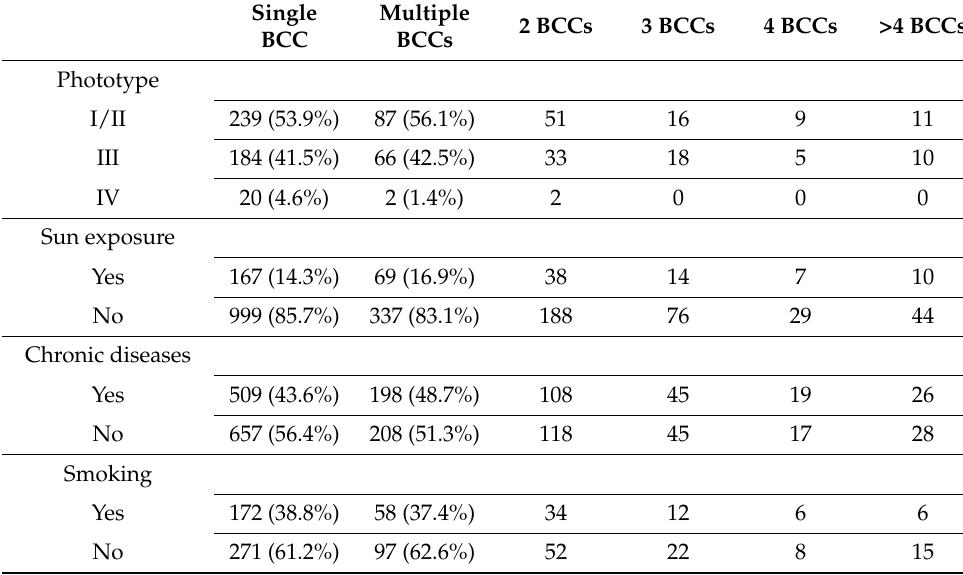
Table 5. Risk factors for single or multiple BCCs.